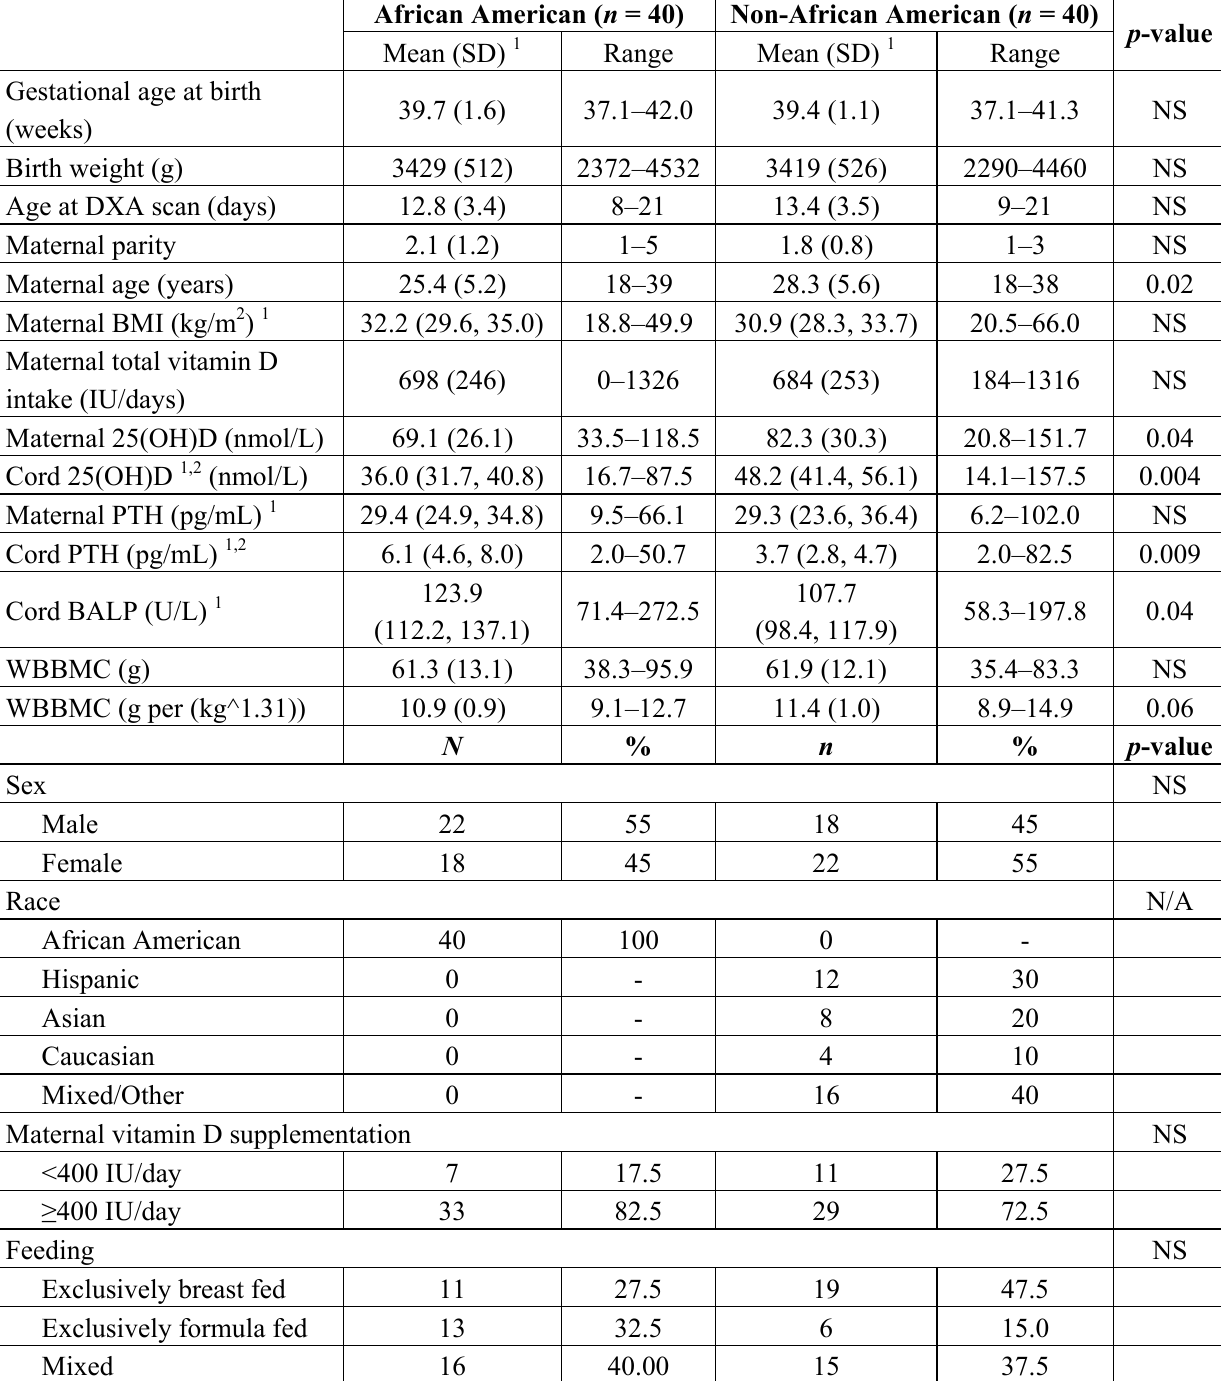
Table 2. Characteristics of African American and non-African American